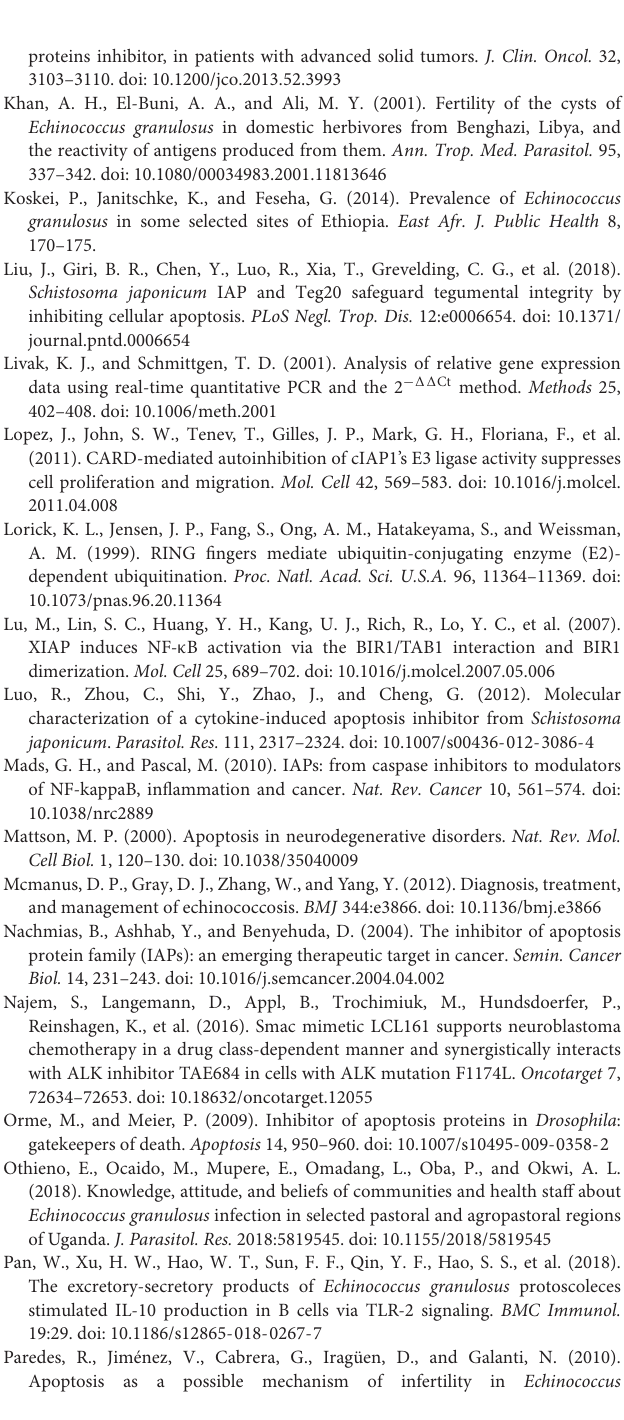
FIGURE S3 | Expression, purification (Lane 1–3) and western blotting (Lane 4–8) of rEg-IAP (A) and rEg-BIRP (B) . M, Molecular mass markers (kDa); lane 1, pET32a(+)-vector; lane 2, pET32a(+)-Eg-IAP/pET32a(+)-Eg-BIRP; lane 3, Purified rEg-IAP/rEg-BIRP; lane 4, Purified rEg-IAP/rEg-BIRP probed with anti-rEg-IAP/anti-rEg-BIRP rabbit sera IgG; lane 5, Purified rEg-IAP/rEg-BIRP probed with pre-immunized rabbit sera IgG; lane 6, Purified rEg-IAP/rEg-BIRP probed with sera from CE-positive sheep sera; lane 7, Purified rEg-IAP/rEg-BIRP probed with CE-negative sheep sera; lane 8, Total protein extracts of PSCs probed with anti-rEg-IAP/anti-rEg-BIRP rabbit sera